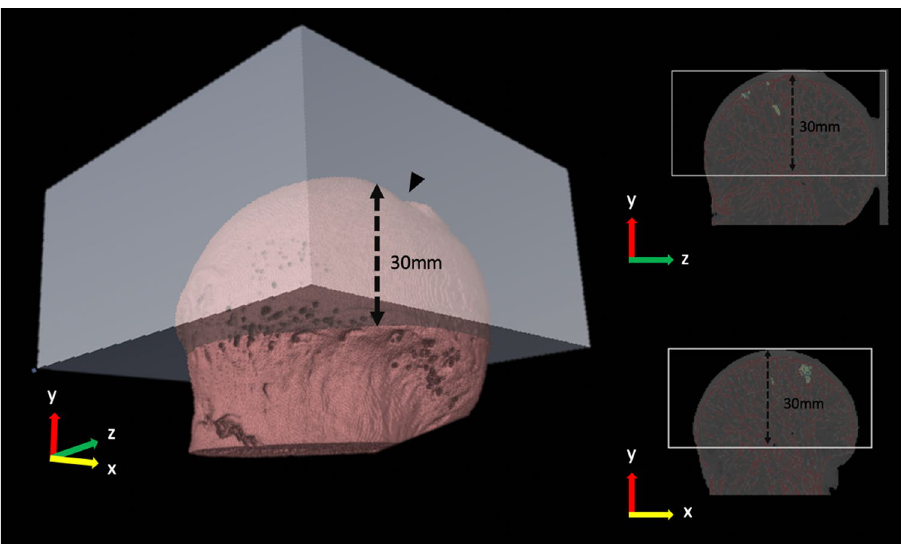
Figure 2. ROI of the femoral head when BMD was directly measured with micro-CT. A spherical cap with 30 mm height was used as this was the volume typically preserved after the retrieval process. Arrowhead indicates the location of fovea capitis which was used as a